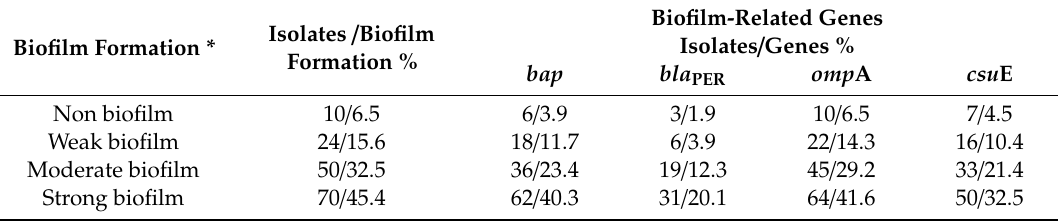
Table 2. Correlation of the biofilm related genes and biofilm